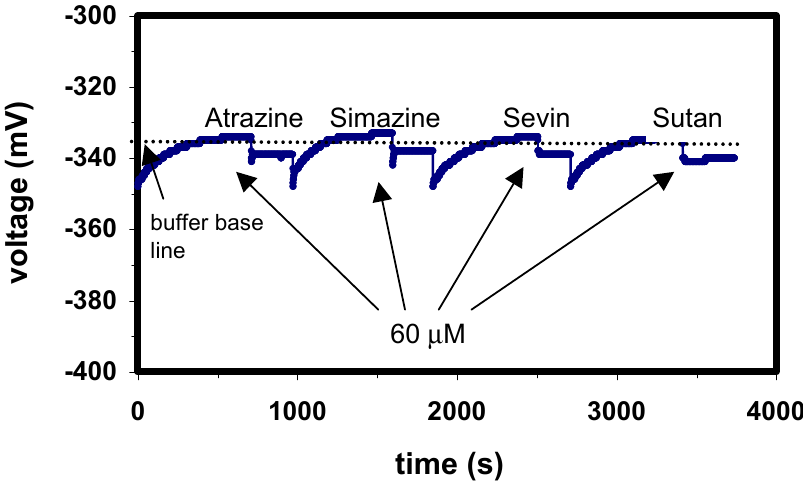
O as pH transducer. The 2 5